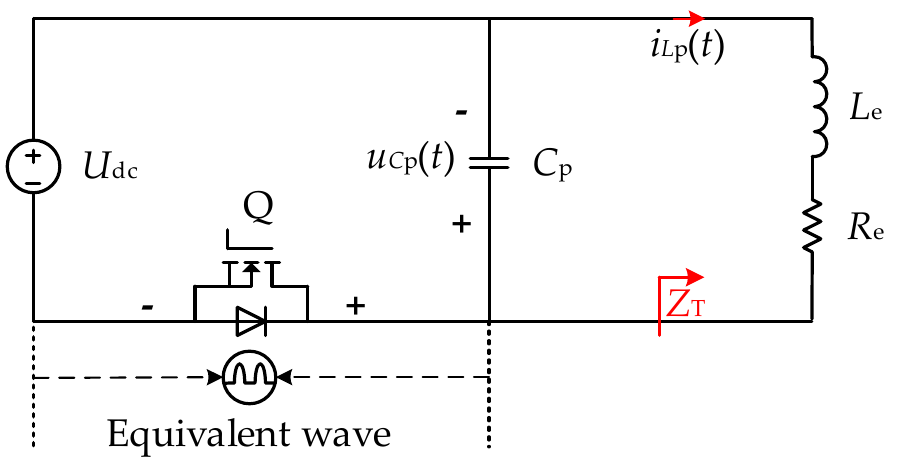
Figure 10. The simplified circuit model.